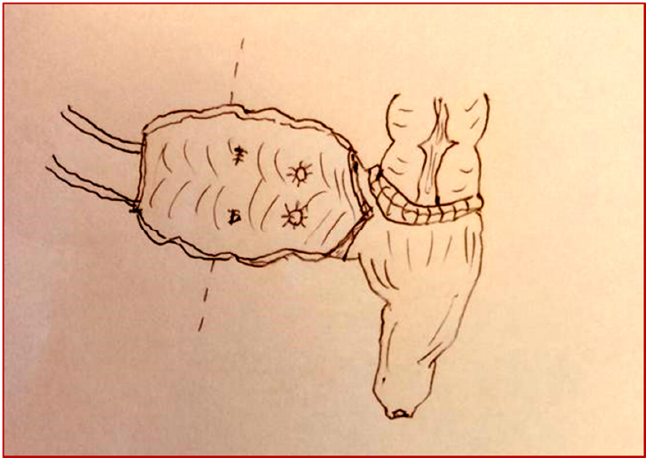
Figure 6. Cologne pouch technique: reimplantation of the ureters with an antirefluxive technique.